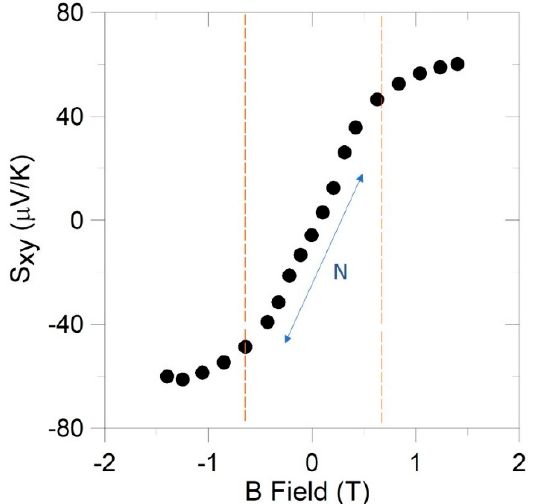
Figure 8. An example of the magnetic field dependence of the Nernst thermopower in the 50 at.% sample in B configuration at 80 K. The curve shows two different regimes, a low field (| B | < 0.6 T) and a high field (| B | > 1 T). The slope is taken at the low field then normalized by the temperature gradient and sample dimensions to calculate the intrinsic Nernst coefficient.